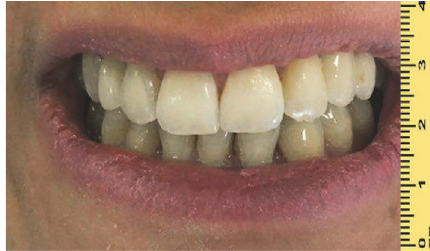
Figure 8: Final restoration delivery view.